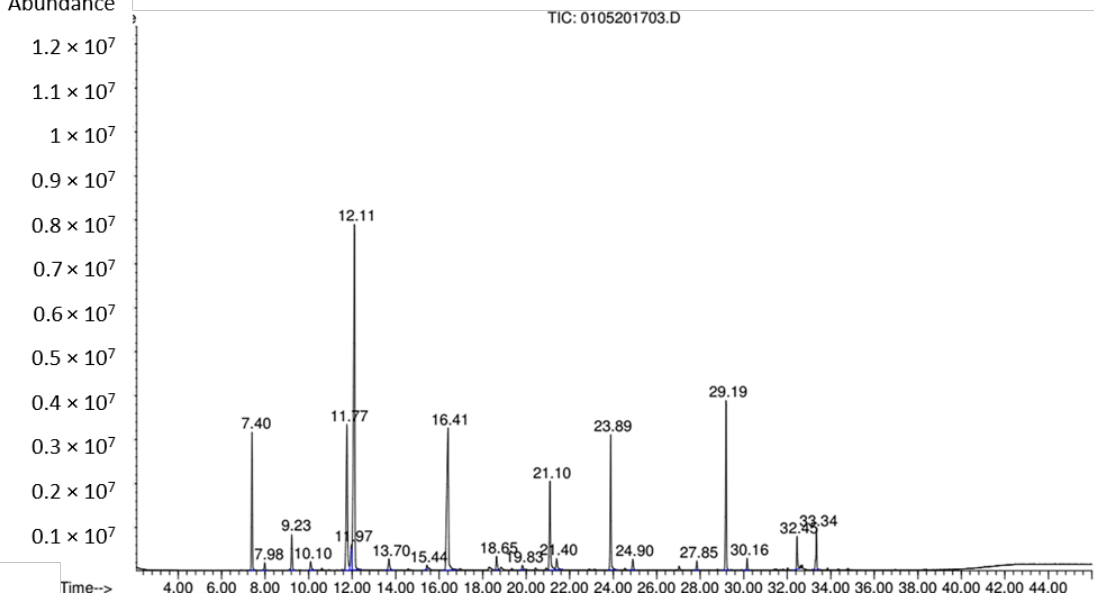
Figure 3. The GC-MS spectrum of marjoram essential oil.